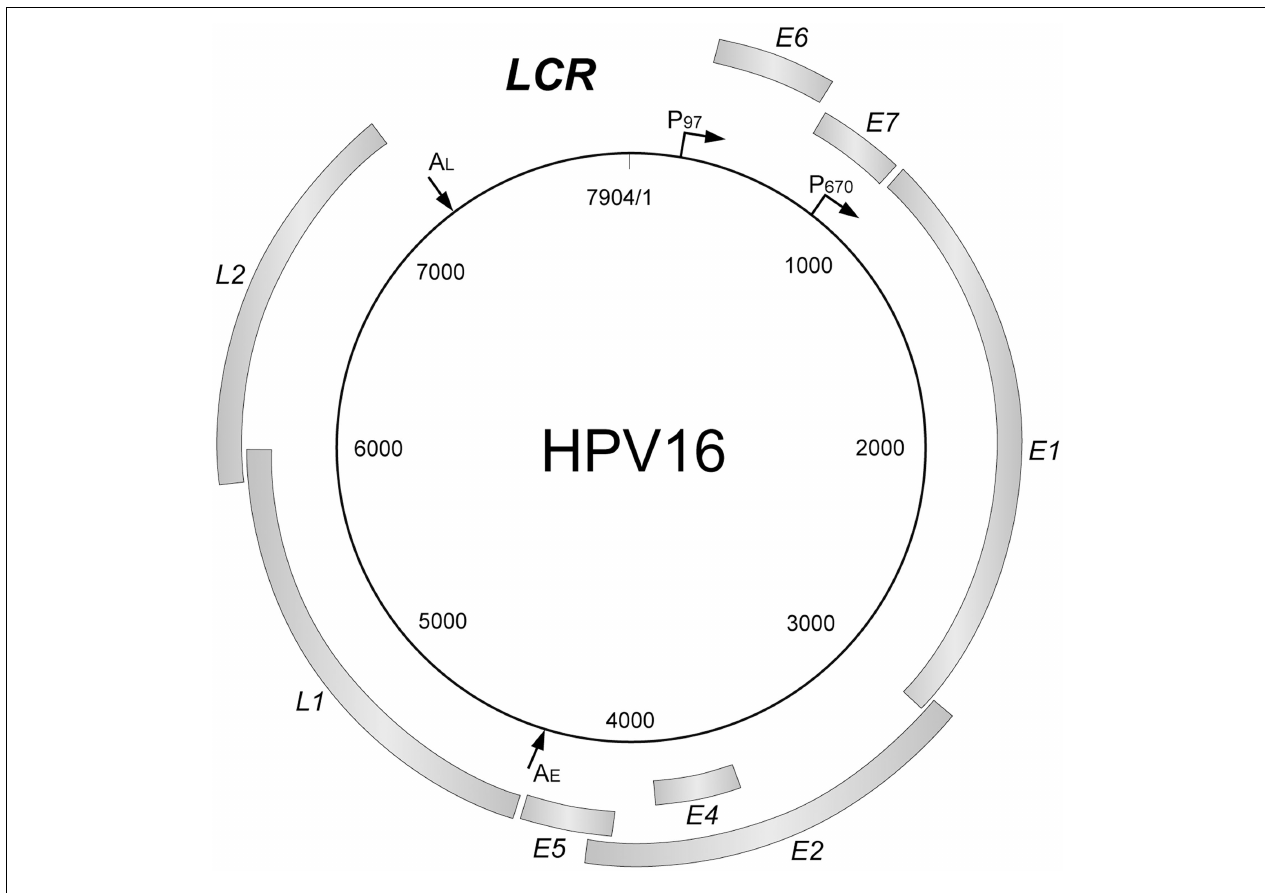
transcriptional control region (long control region; LCR). LCR contains a DNA replication origin and functions as the regulator for the DNA replication.The major promoters and polyadenylation signals are indicated (P97, P670, AE,